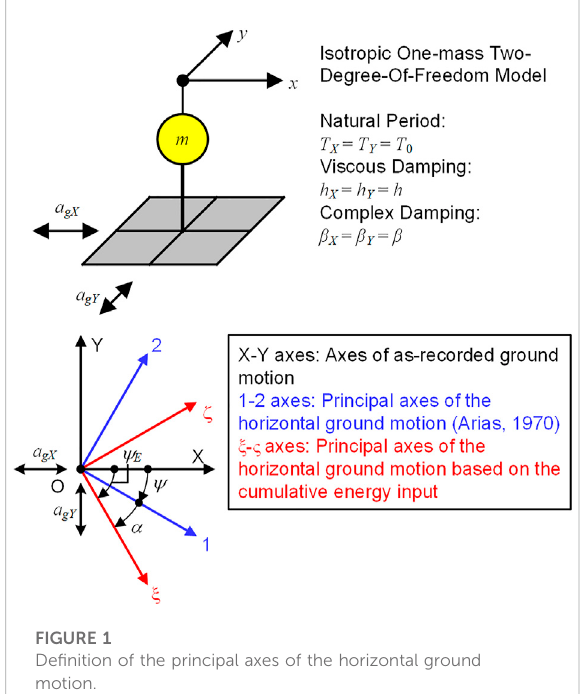
FIGURE 1 De fi nition of the principal axes of the horizontal ground